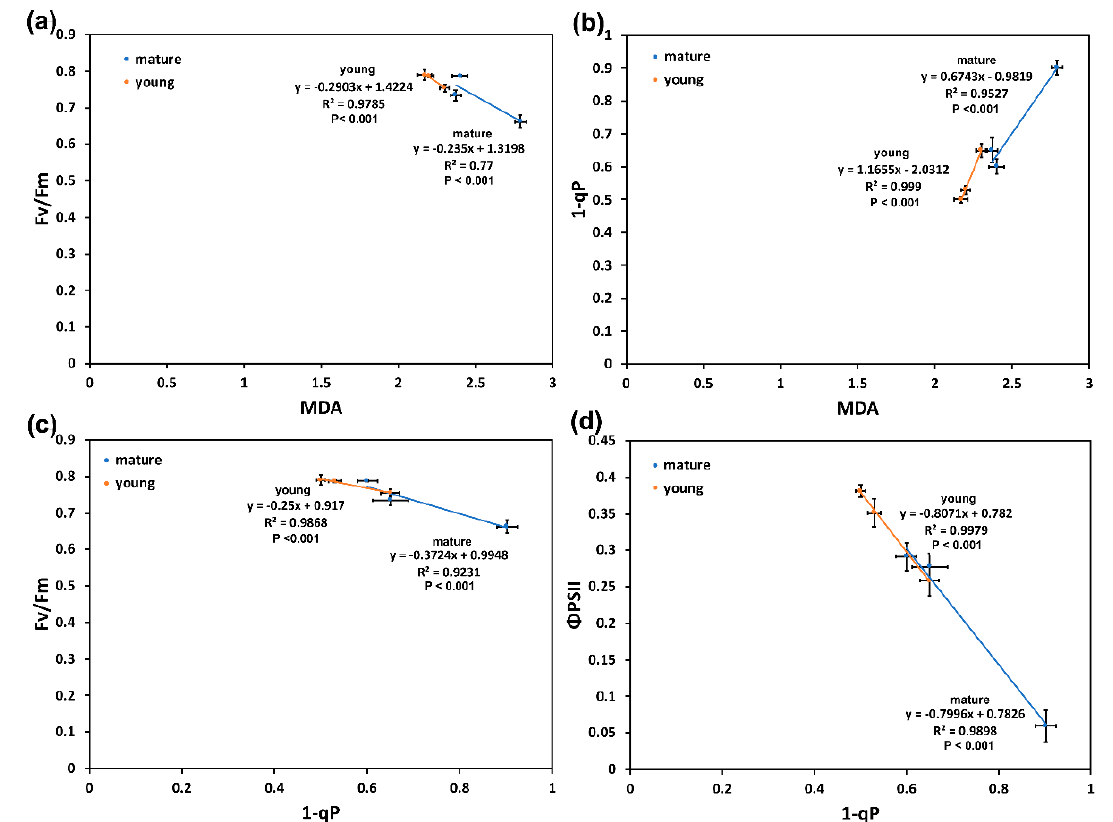
Figure 5. The relationship between the maximum efficiency of PSII photochemistry ( F v / F m ) and the level of lipid peroxi- dation, measured as malondialdehyde (MDA) ( a ), the level of MDA with the level of excitation pressure (1 − q p ) ( b ), the level of excitation pressure (1 − q p ) with F v / F m ( c ) and the effective quantum yield of PSII photochemistry ( Φ PSII ) with 1 − q p ( d ), in both A. thaliana young leaves (YL) and mature leaves (ML) at the three DS treatments. Error bars represent ± standard error of the mean (n = 5–6).